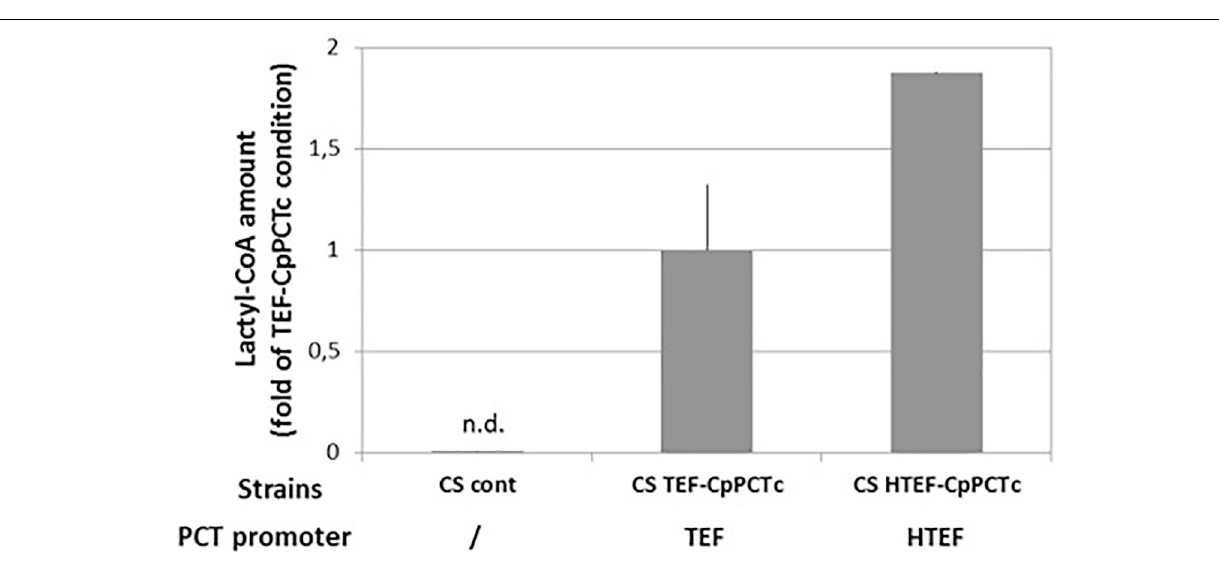
FIGURE 7 | Quantification of lactyl-CoA produced in strain expressing C. propionicum cytosolic PCT protein under the control of different promoters. Strains were grown for 24 h on minimum medium containing a mixture of 10 g/L of lactic acid. After a normalization, results were expressed as fold of CS TEF-CpPCTc strain result. For clarity purposes, only half error bars have been represented. N = 3 independent